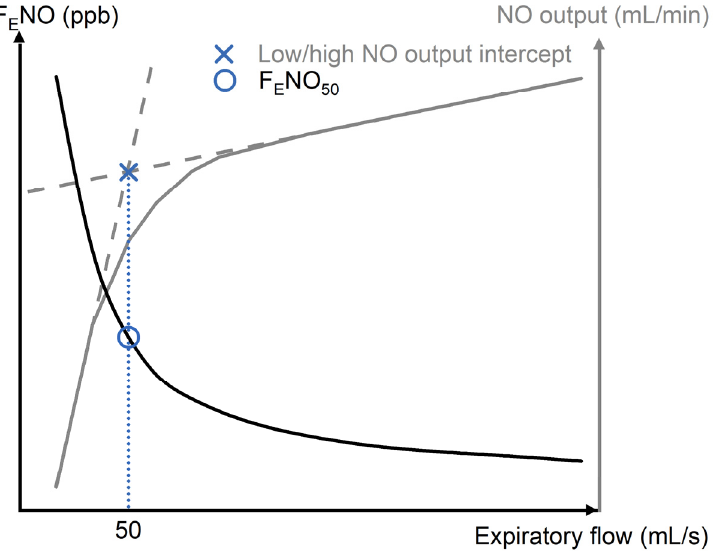
Figure 4. The fraction of exhaled of nitric oxide (F E NO) and NO output as a function of expiratory flow, whereby 50 mL/s is recommended as the standardised flow for the F E NO breath test (specified as F E NO 50 ; see text). The F E NO value is derived from the intercept of the regression lines for low and high NO output, as illustrated. (Figure adapted from [79]).